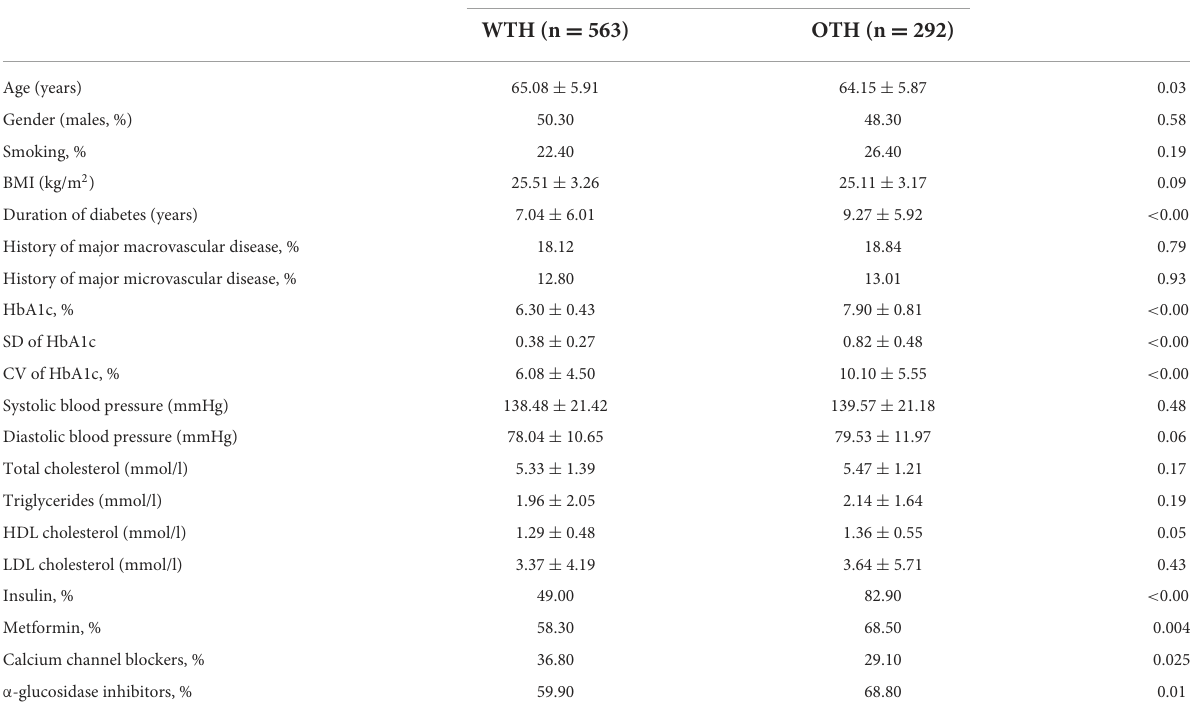
TABLE 1 Characteristics of the study population by the target range of HbA1c in the intensive glucose control. Characteristic Intensive glucose control